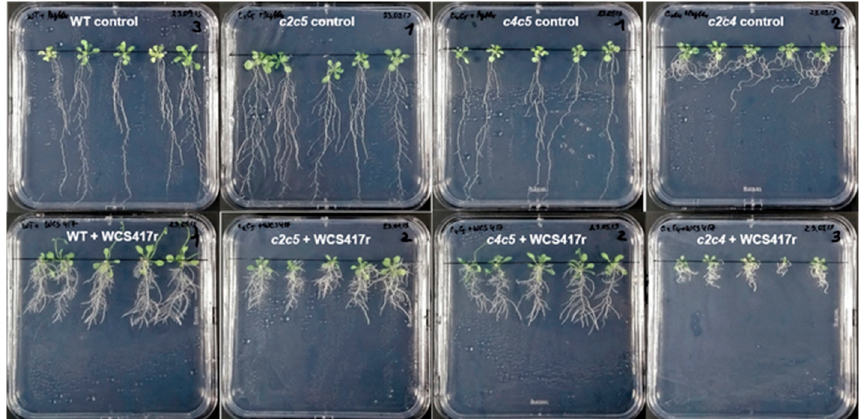
Figure 5. Visual phenotype of Arabidopsis WT and double mutants treated with P. simiae WCS417r. Seedlings of Arabidopsis WT and double mutants c2c5 , c4c5 , and c2c4 were cultivated without (upper row) and with P. simiae WCS417r (lower row) for two weeks.